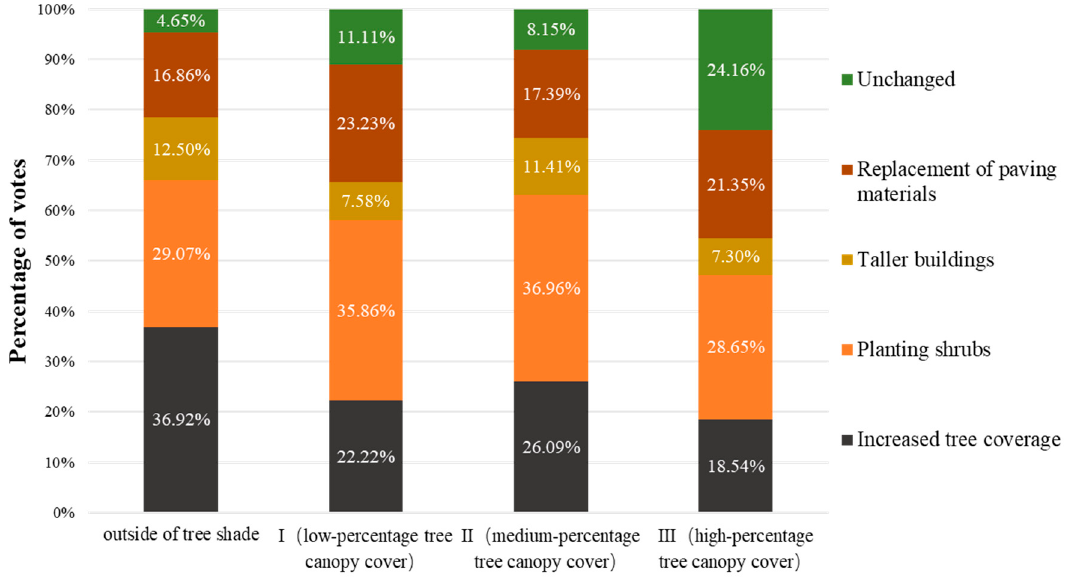
Figure 12. Participant responses regarding suggested methods to improve thermal comfort under different degrees of tree canopy cover.